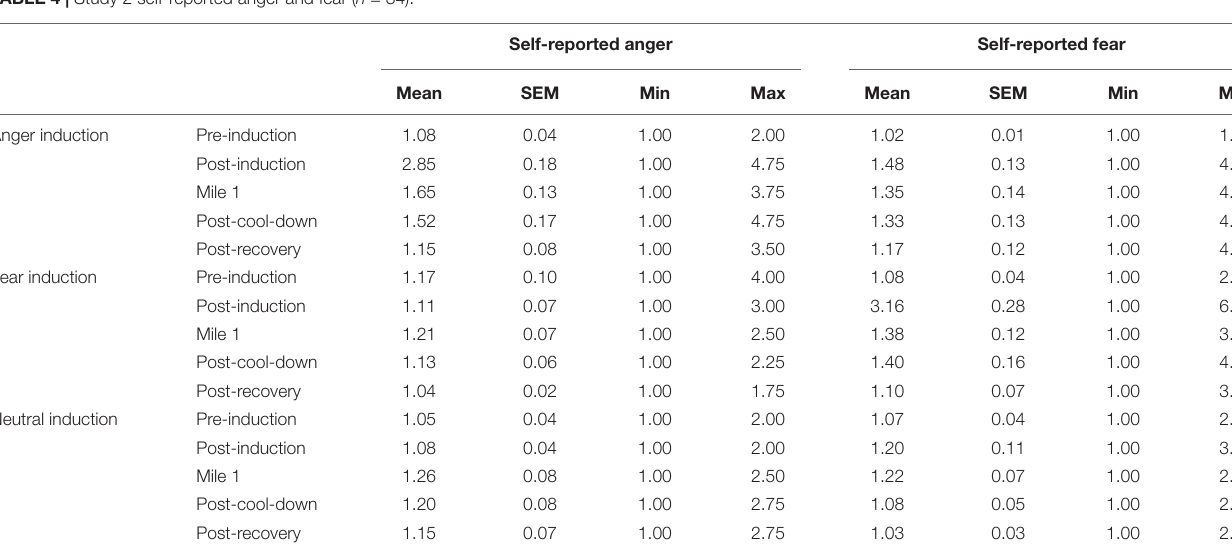
FIGURE 2 | Two mile run time means (SEM) for each motivational state induction and running speed. TABLE 4 | Study 2 self-reported anger and fear ( n =